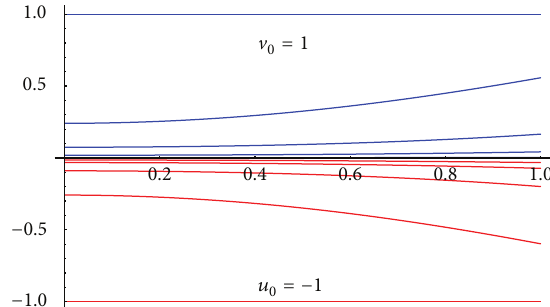
Figure 2: Plot of 𝑢 𝑛 (red) and V 𝑛 (blue), 𝑛 = 0,1, 2, 3,4 for 𝜆 = 0.9 .